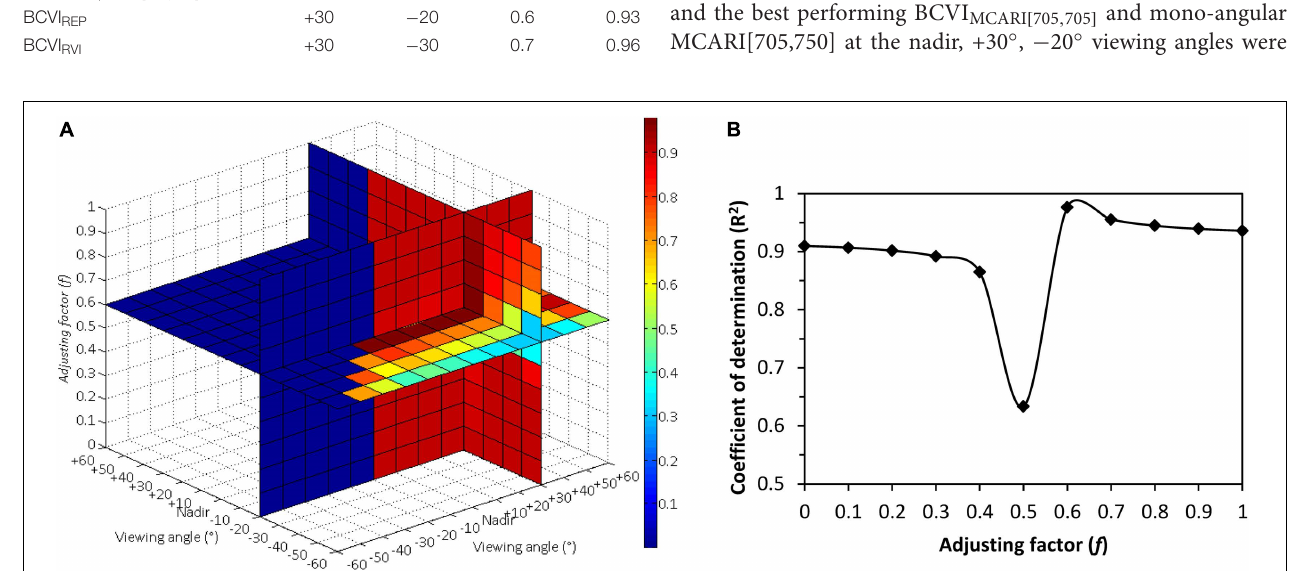
Frontiers in Plant Science |